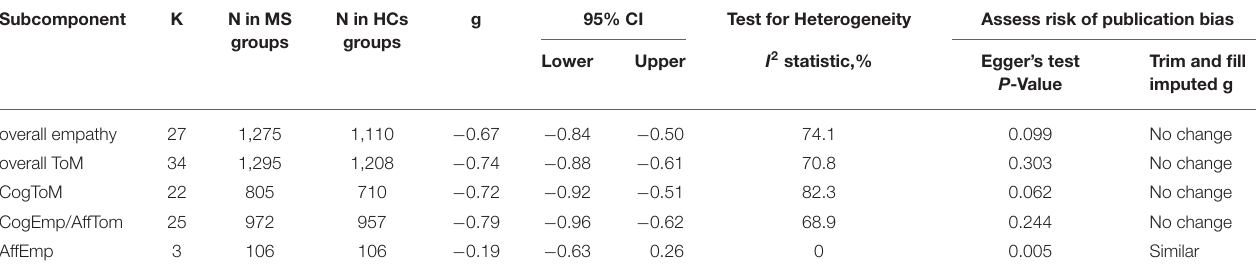
Trim and fill P -Value imputed g